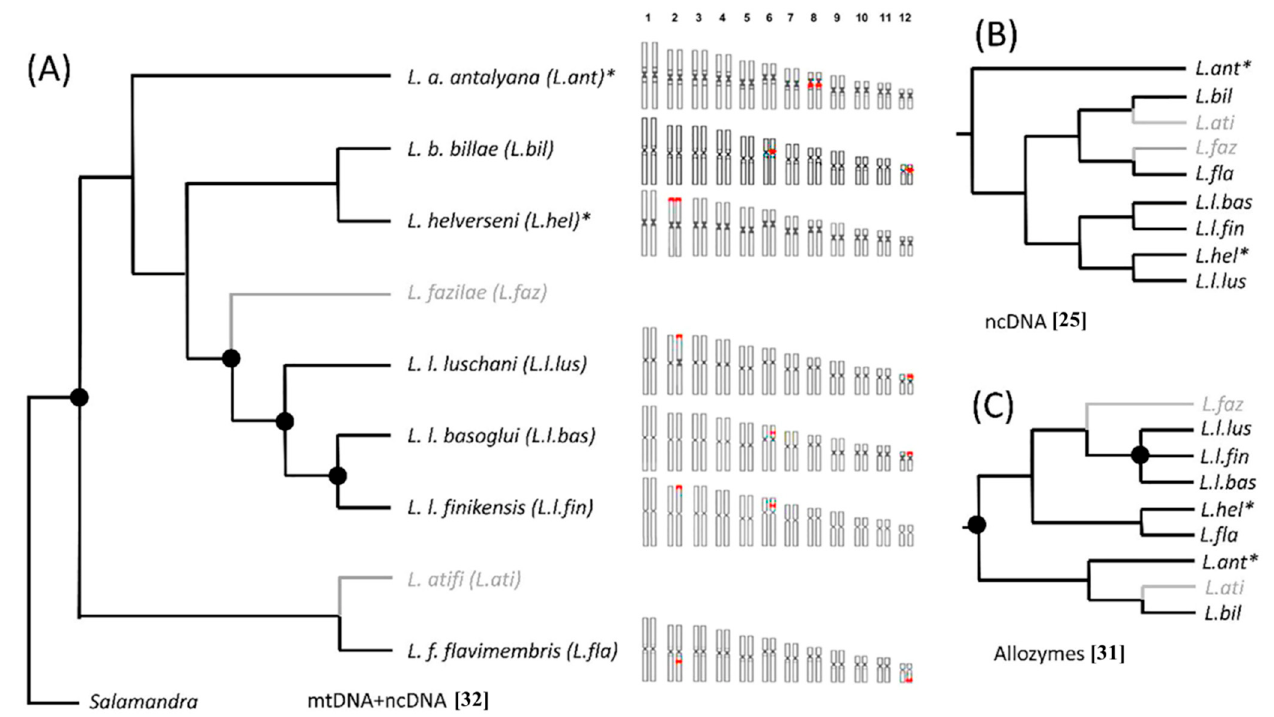
Figure 5. ( A ) Karyograms of the studied taxa of Lyciasalamandra superimposed on the phylogenetic relationships redrawn from Ehl et al. [32]; ( B ) alternative topology based on ncDNA [25]; ( C ) alternative topology based on allozymes [31]. Taxa not included in the cytogenetic analysis are given in grey; filled dots indicate nodes with high posterior support values in the original paper; the asterisks indicate taxa with paired homomorphic NOR loci.